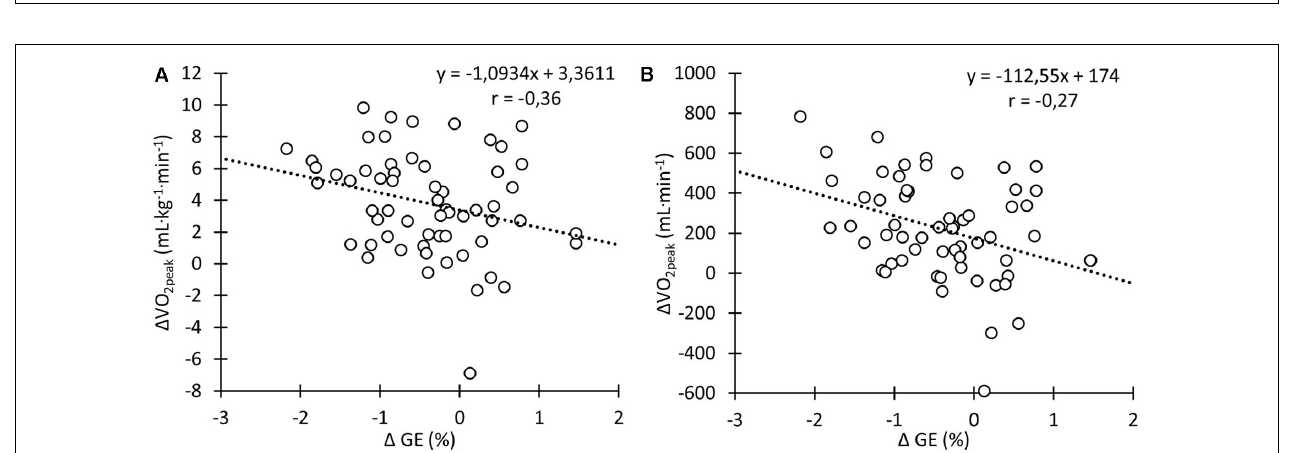
FIGURE 5 | Correlation between the change in time trial performance during the training intervention and initial time trial performance (Power 40min ) in absolute units (A) and normalized for body mass (B) .